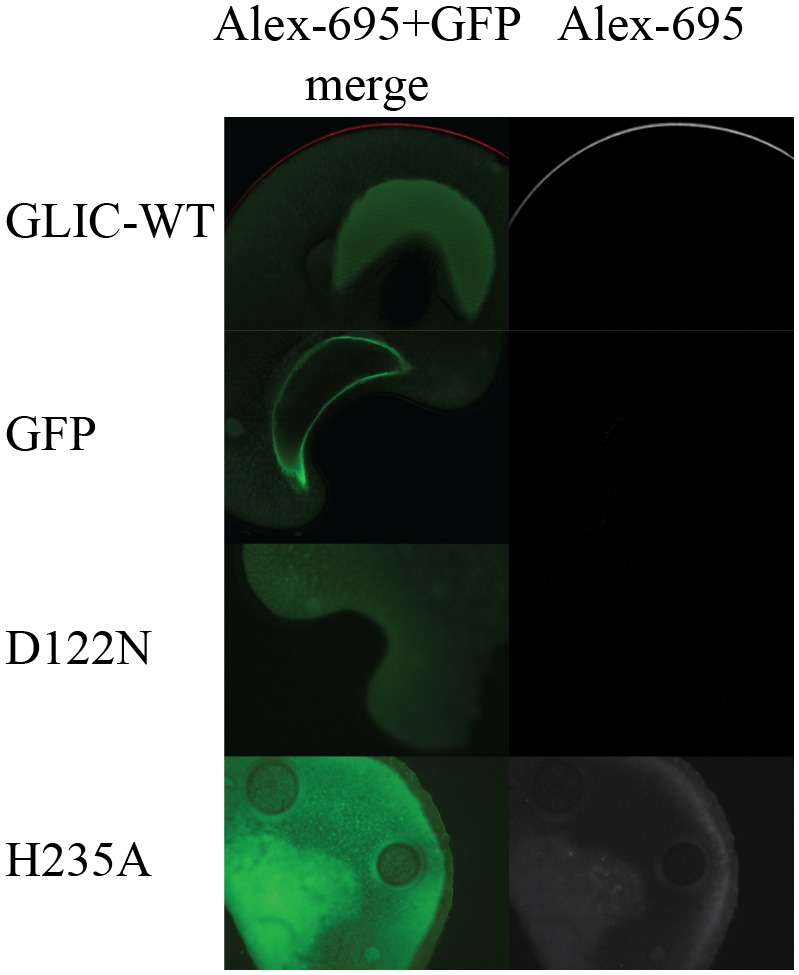
Protein expression of nonfunctional mutants.Rabbit anti-HA tag Alexa Fluor-695 immunostaining results of the mutants that produced no detectable current in functional tests, compared to Wt and GFP-alone injected oocytes. Left, colored merge of GFP and Alexa-695 and right, the Alexa-695 imaging alone. Both D122N and H235A show no expression. GLIC, G. violaceus ligand-gated ion channel; GFP, green fluorescent protein; HA, human influenza hemagglutinin; Wt, wild-type.